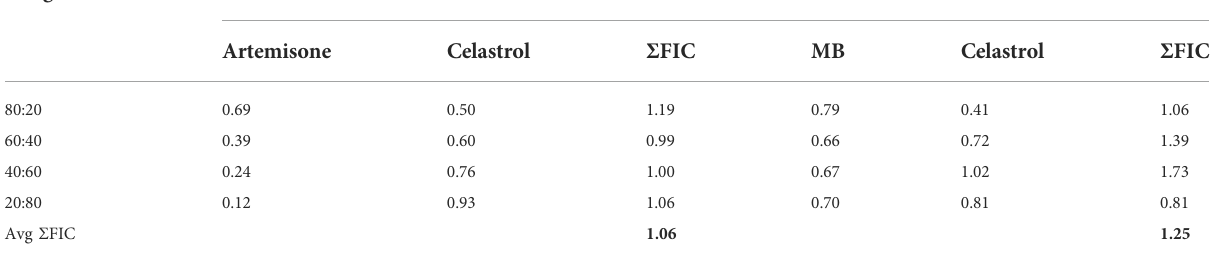
TABLE 3 FIC values for artemisone and MB in combination with celastrol against asexual blood stage Pf NF54. a